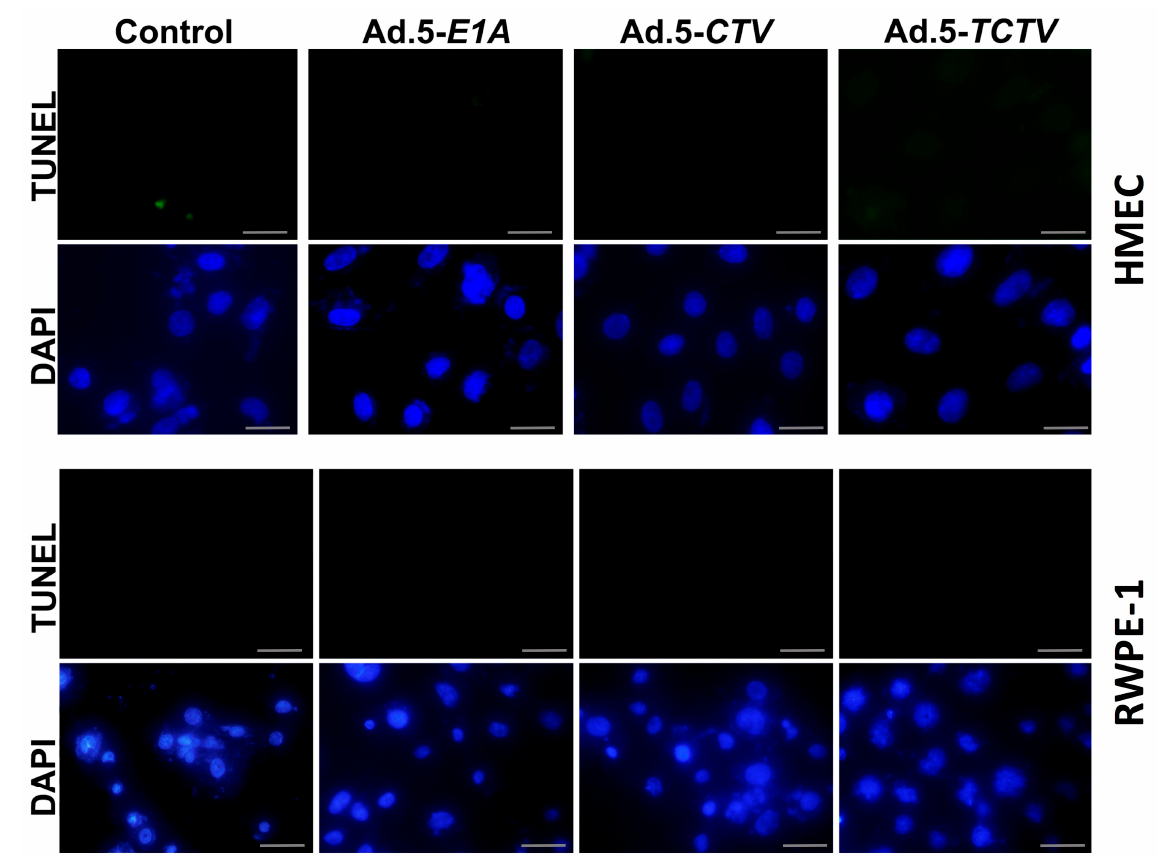
Figure 4. The TCTV does not induce apoptosis in normal breast and prostate epithelial cells. Normal primary breast epithelial (HMEC) and normal immortal prostate epithelial (RWPE-1) cells were cultured in 8-well chamber slides and treated with 25 pfu of Ad.5- E1A , Ad.5- CTV, or Ad.5- TCTV for 72 h. Cells were fixed and TUNEL assays were performed. Data presented as TUNEL positive cells in a defined microscopic field as compared with the un-treated control cells. Scale bar: 200 μ M.